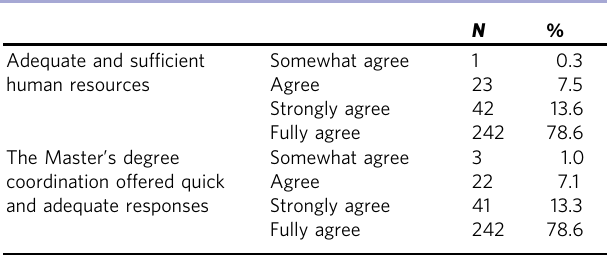
From: Data obtained in question no. 9 of the survey (closed, scaled, on a scale from 1: completely disagree, to 5: completely agree). Compiled by the authors through the SPSS.